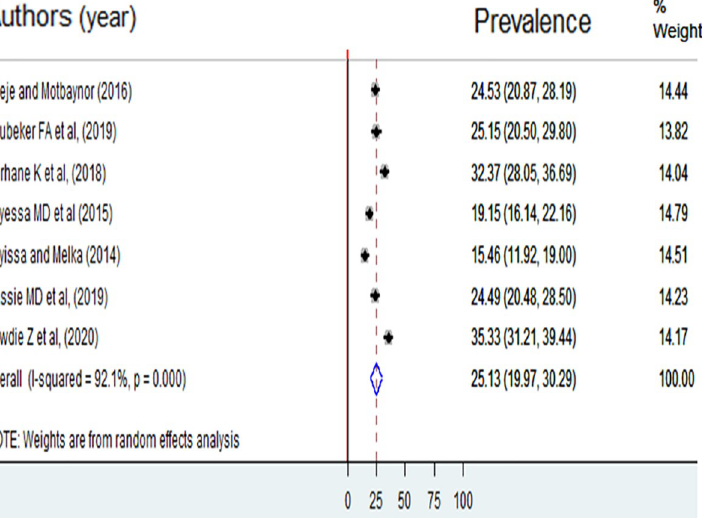
Fig 2. Prevalence of unmet need for family planning among reproductive-age women living with HIV in Ethiopia, 2013 to 2018.